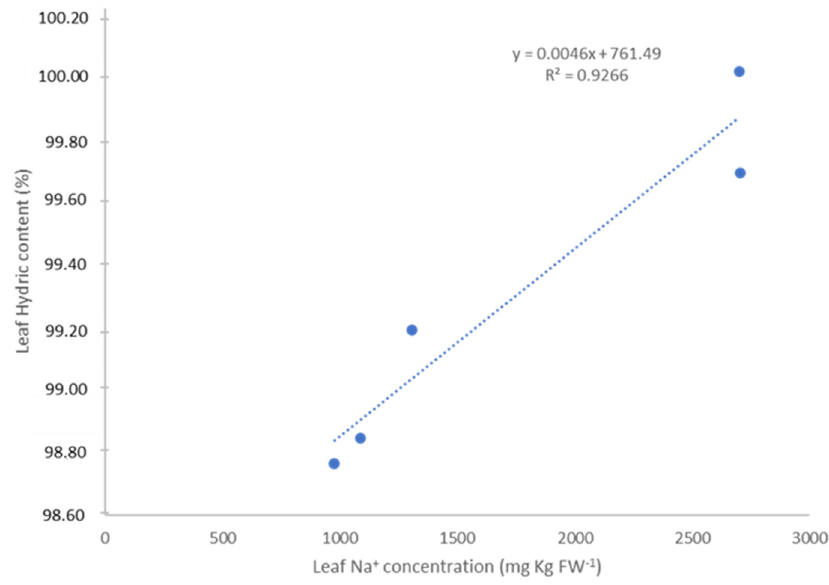
. Figure 2. Correlation between leaf hydric content and leaf Na + Figure 2. Correlation between leaf hydric content and leaf Na + concentration. Table 2. The content of cations (Mg +2 , Ca +2 , K + , NH 4+ , Na + and K/Na ratio) (mg kg − 1 FW) in the leaf tissues of C. maritimum under the different treatments (Control1, Control2, NaCl, MeJa, NaCl + MeJa), ( n = 10). Columns with different letters (a, b, c) for each variable differ significantly according to Tukey’s test ( p < 0.05).